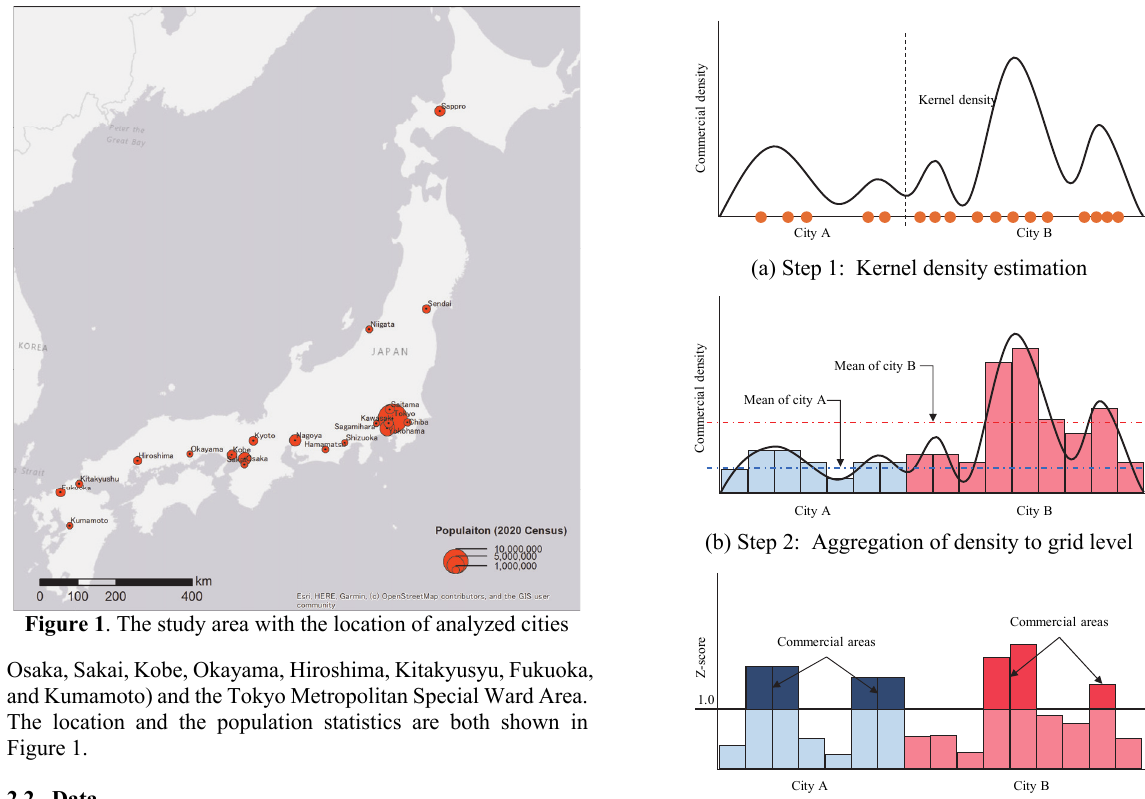
(c) Step 3: Extraction of commercial area based on Z-score Figure 2 . Process for extracting a commercial